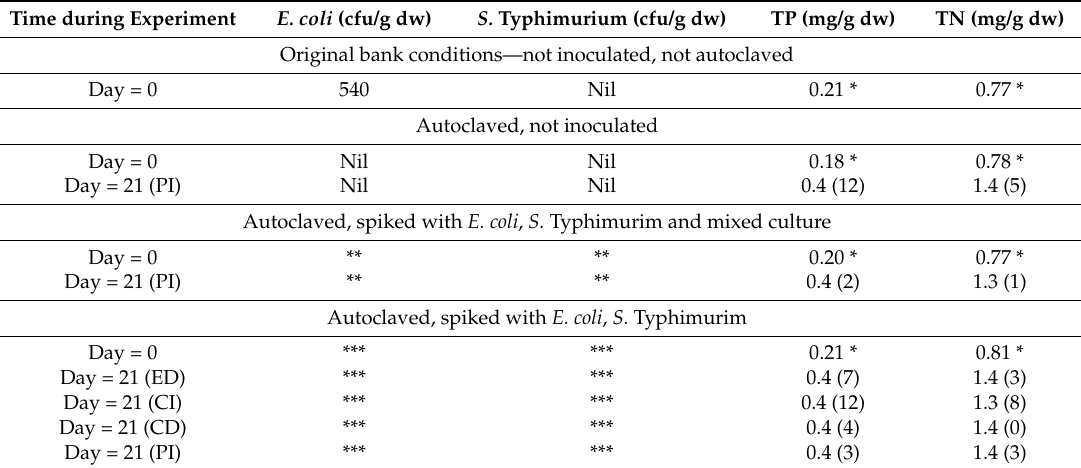
Table A1. Mean (and relative standard deviations in %) of total phosphorus (TP) and total nitrogen (TN) concentrations of sediment samples.